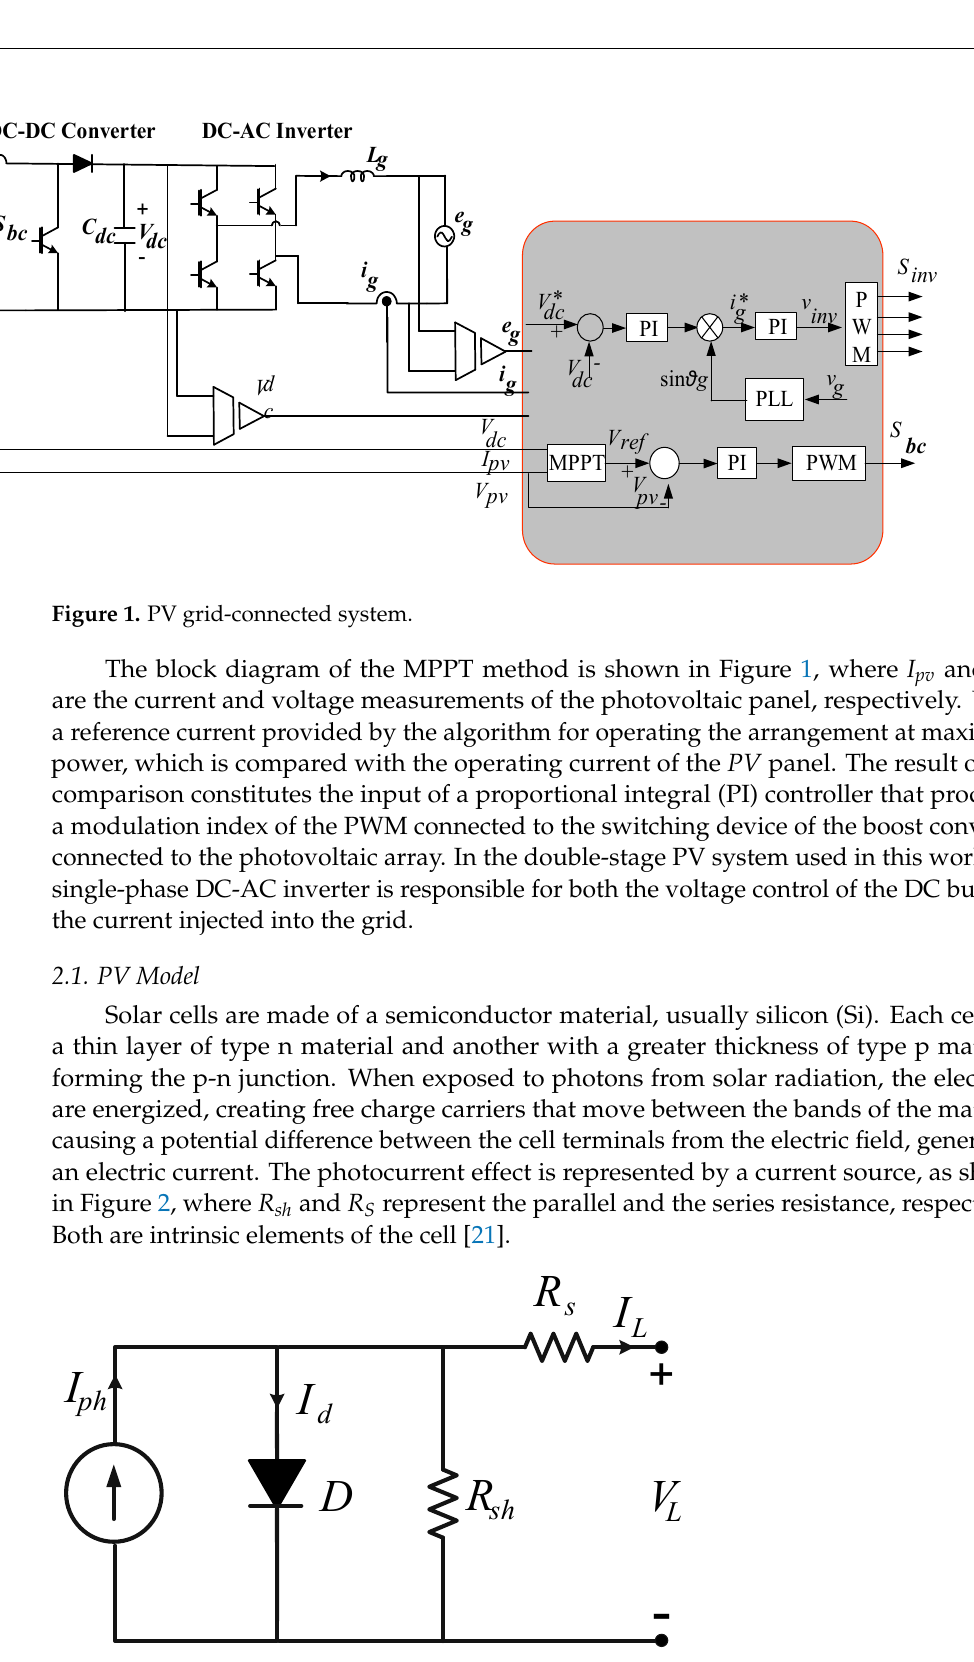
Figure 2. PV equivalent circuit